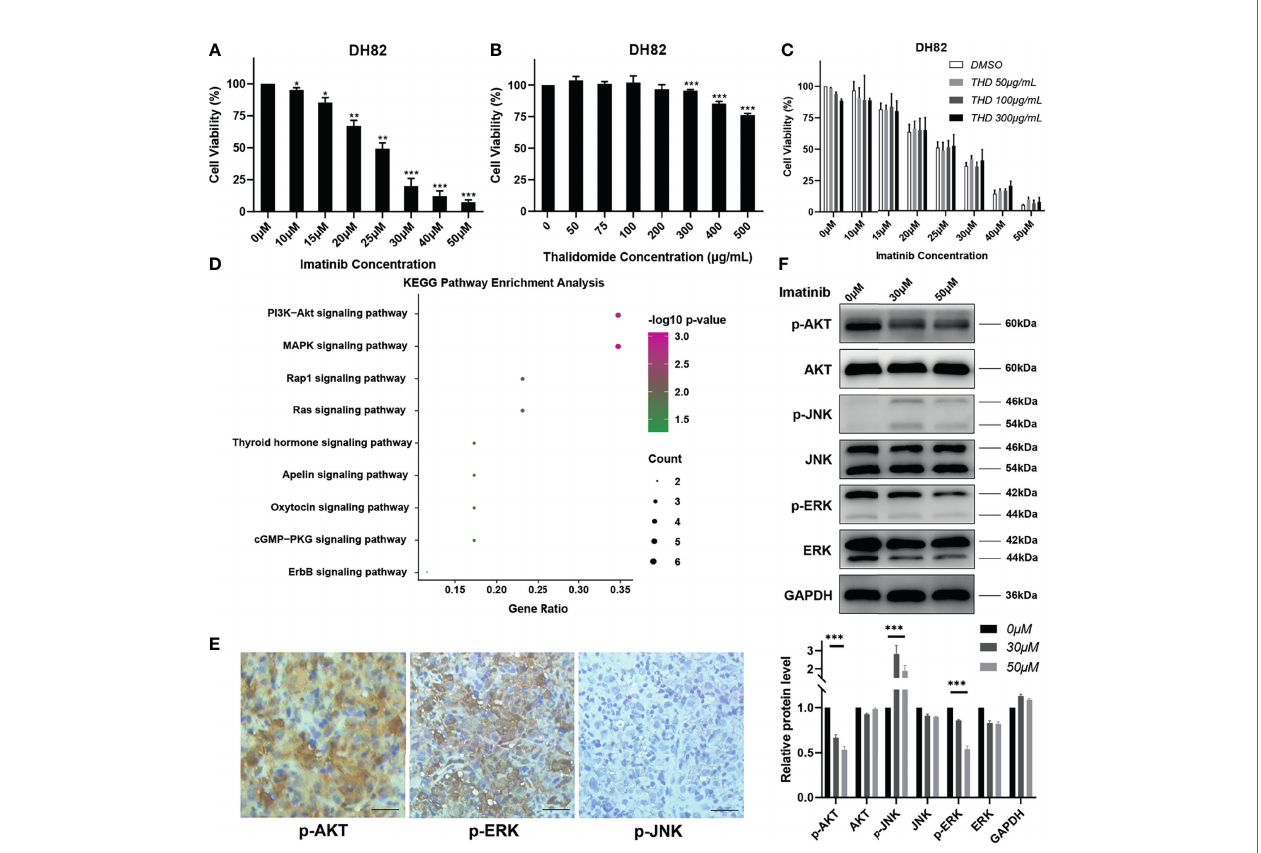
FIGURE 3 | Imatinib could inhibit MAPK and PI3K/AKT pathways in vitro . (A – C) Cells were exposed to different concentrations of imatinib, thalidomide (THD), and imatinib + thalidomide. Cell viability was assessed using CCK8 assays after treatment for 24 h. Data were obtained from three independent experiments. * p < 0.05, ** p < 0.01, *** p < 0.001 vs. each control group. (D) KEGG pathway enrichment analysis of gene mutations in patient. (E) Representative immunohistochemistry staining images of p-AKT, p-JNK, and p-ERK in patient ’ s tumor tissues (magni fi cation, ×200). (F) Total proteins were collected from the treated DH82 cells, and Western blot analyses for the expression of p-AKT, AKT, p-JNK, JNK, p-ERK, and ERK were performed. GAPDH was used as a loading control. Data were obtained from three independent experiments. *** p < 0.001 vs. each control